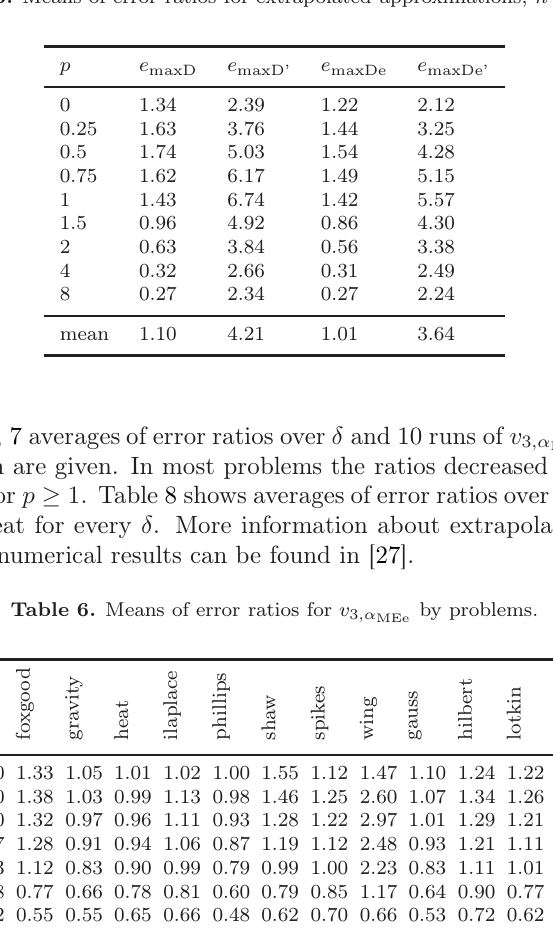
Table 5. Means of error ratios for extrapolated approximations, n = max .